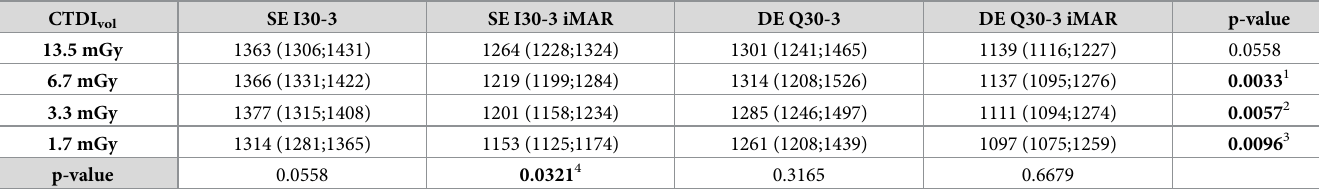
Table 1. HU values at the trocar tip (TROCAR) with median and 1st and 3rd percentiles in brackets. CTDI